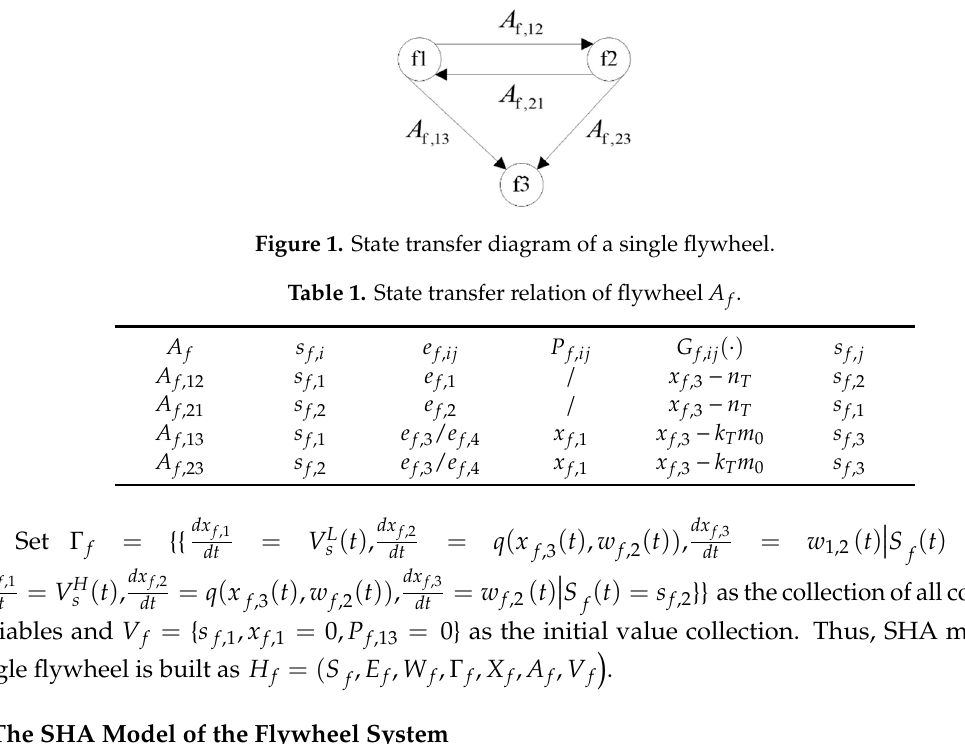
Figure 3. Dynamic Fault Tree (DFT) of the flywheel system. Table 2. Comparison between traditional methods and DFT- Stochastic Hybrid Automaton (SHA) method.